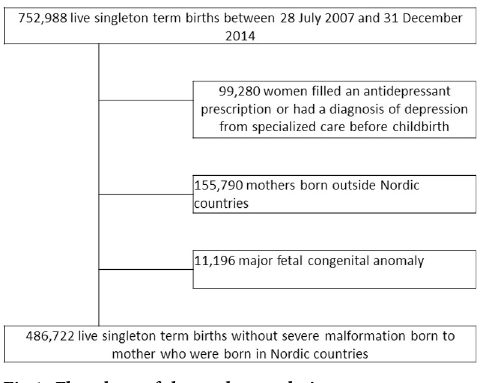
Fig 1. Flowchart of the study